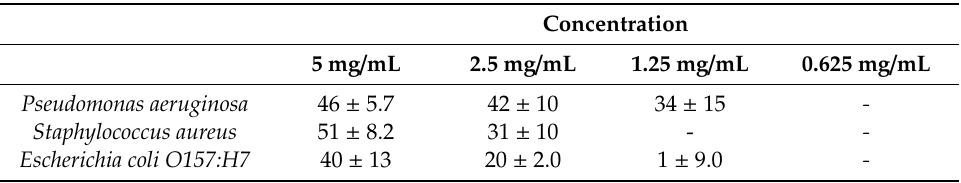
Table 2. Percentage Inhibition of